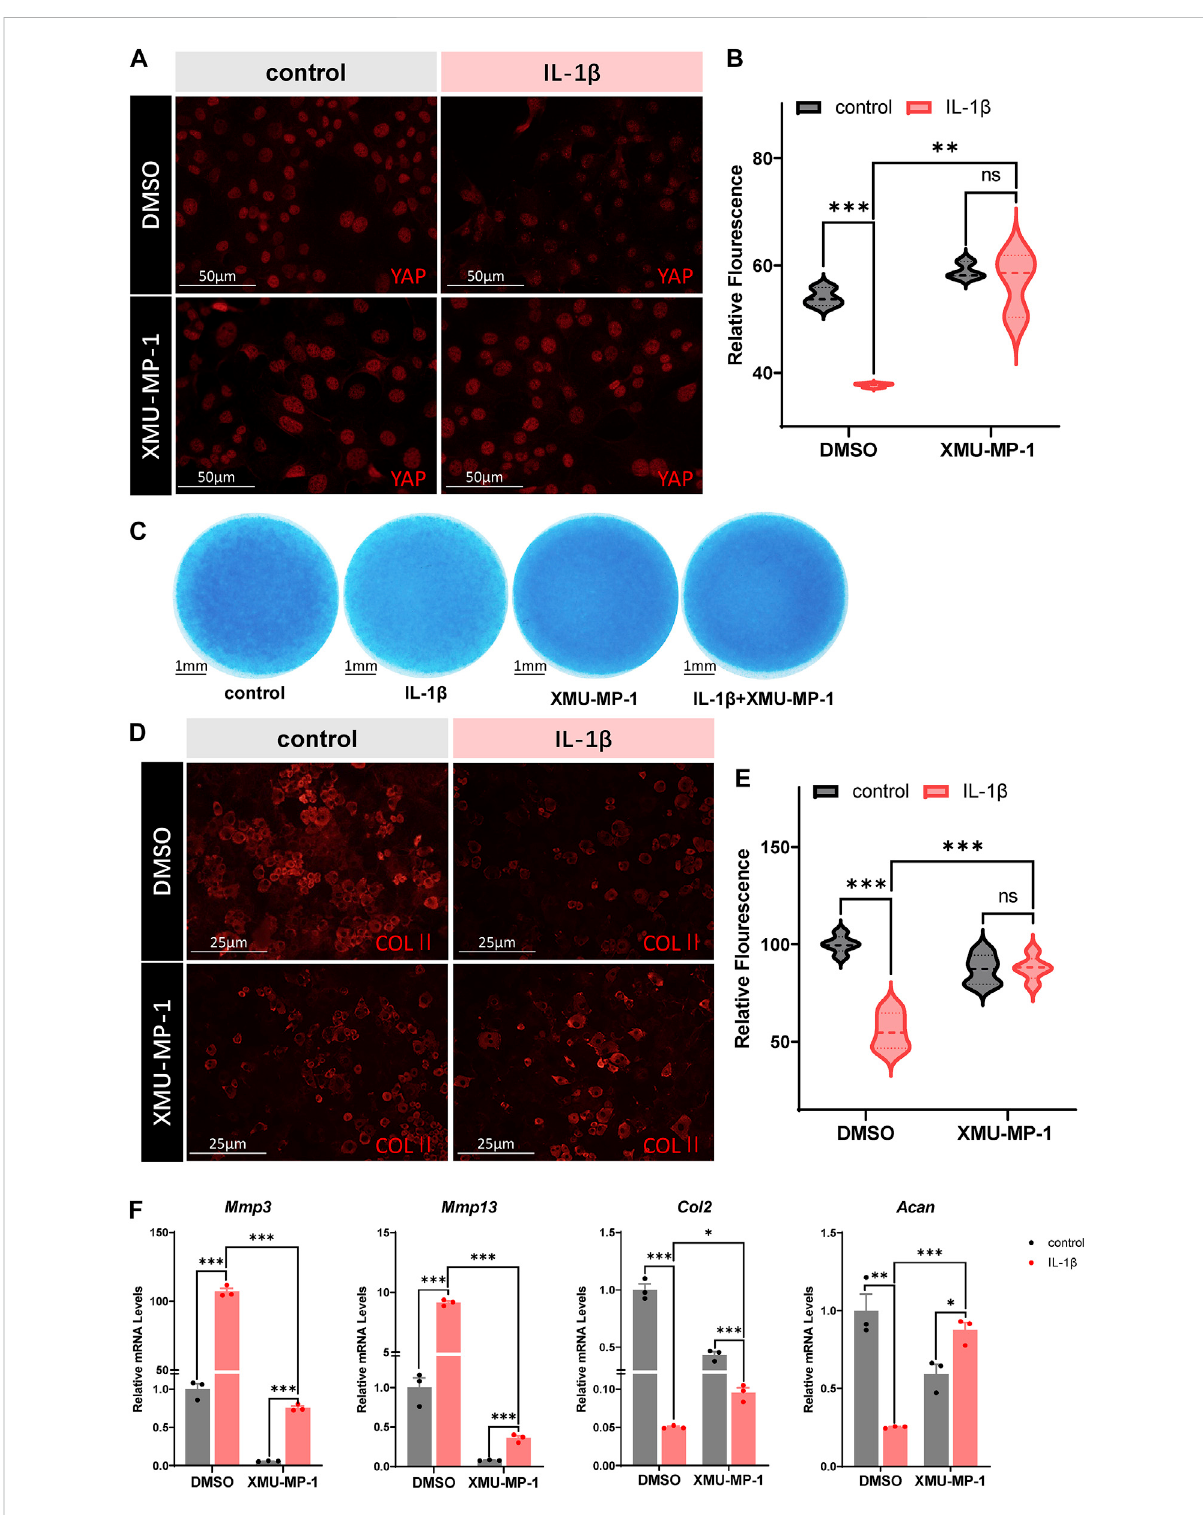
FIGURE 2 ProtectiveeffectsofXMU-MP-1onECMdegradationandchondrogenesis. (A) Representativeimagesofculturedprimarychondrocytestreated with IL-1 β or/and XMU-MP-1 for 48 h. Cells were immunostained with antibody against YAP (red). (B) Statistical analysis of relative fl uorescence of YAP in cultured chondrocytes in A. n = 3, 3, 3, 3. (C) Representative images of chondrocyte micromass cultures treated with IL-1 β or/and XMU-MP- 1 for 48 h. The micromass cultures were subjected to Alcian blue staining. (D) Representative images of cultured primary chondrocytes treated with IL-1 β or/and XMU-MP-1 for 48 h. Cells were immunostained with antibody against COLII (red). (E) Statistical analysis of relative fl uorescence of COLIIinD.n=5,5,5,5. (F) RelativemRNAlevels of Mmp3 , Mmp13,Col2 ,and Acan inprimarychondrocytes treatedwithIL-1 β or/andXMU-MP-1for 48 h. All data are presented as mean ± SEM. ns p > 0.05, ** p < 0.01, *** p <